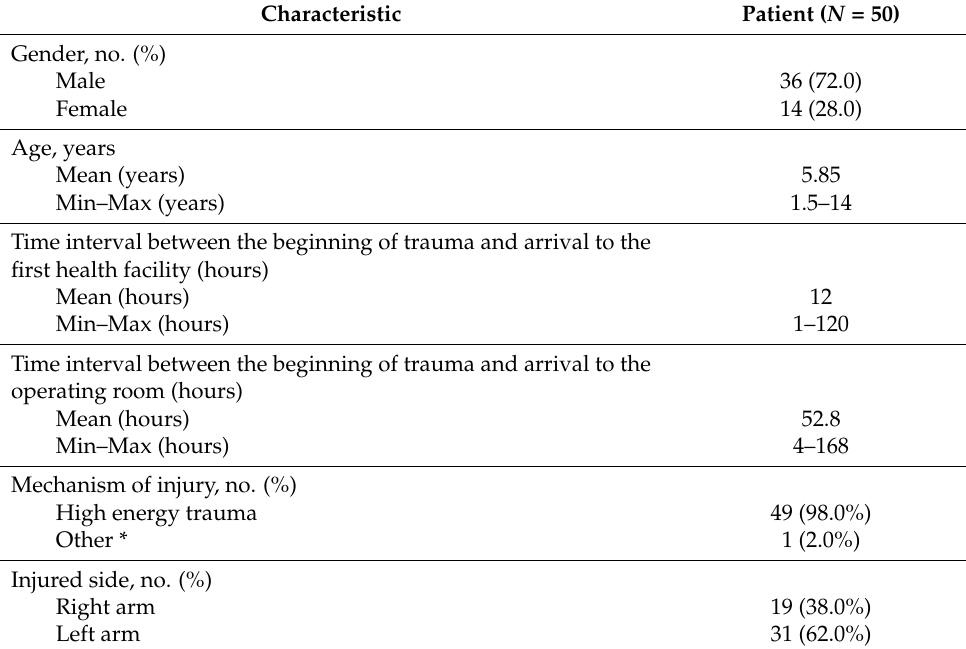
Table 1. Clinical characteristics at